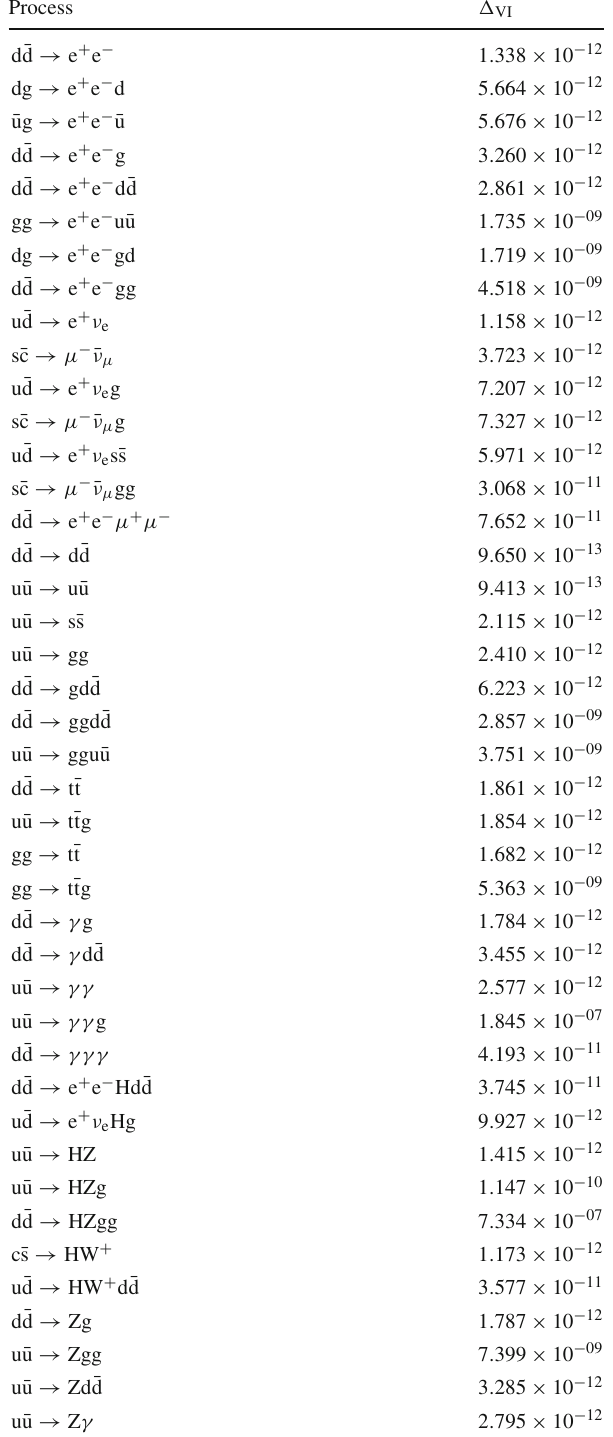
Table 1 Average relative deviations (cid:5) VI between Sherpa + Recola and Sherpa +O pen L oops for the sum of the NLO QCD virtual and integrated-dipole contributions evaluated for 1000 phase-space points. The average relative deviations are calculated by averaging the loga- rithms of the relative deviations between the two results for the consid- ered phase-space points